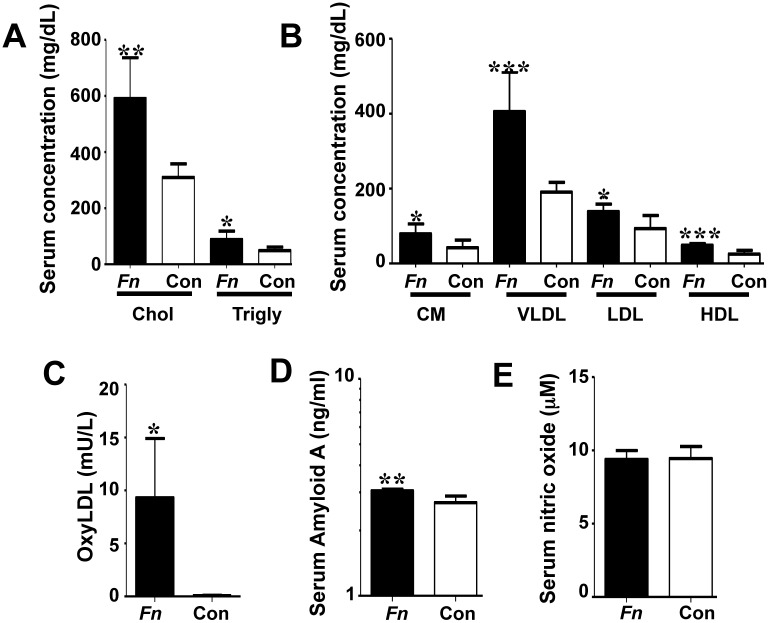
Chronic oral infection with F. nucleatum significantly alters serum risk factors for atherosclerosis.(A) Twenty four-week-infected mice (n = 6) developed significantly elevated levels of total serum cholesterol and total serum triglycerides relative to sham-infected mice (n = 6). (B) F. nucleatum infected mice developed significantly elevated levels of chylomicrons (CM), very low density lipoproteins (VLDL), low density lipoprotein (LDL) and high density lipoproteins (HDL) relative to sham-infected mice (n = 6). (C) Infection significantly increased the total serum oxyLDL in infected mice. (D) Infected mice exhibited significantly elevated acute phase inflammatory protein serum amyloid A at 24 weeks. (E) Infection with F. nucleatum did not significantly alter the concentration of serum nitric oxide at 24 weeks of infection. Fn—F. nucleatum infected mice, Con—control, Chol—cholesterol, Trigly—triglycerides, CM—chylomicrons, VLDL—very low density lipoprotein, LDL—low density lipoprotein, HDL—high density lipoprotein. * P<0.05, ** P<0.01, *** P<0.001.